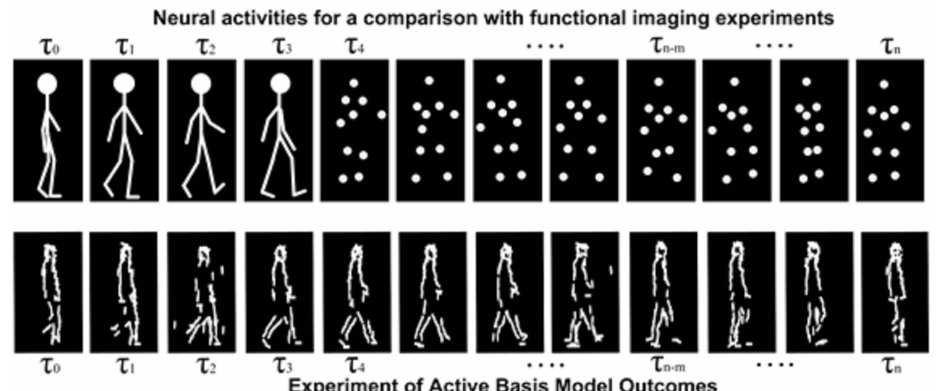
Figure 2. A illustrative similarity comparison of MLD and ABM [15] from the perception of biological movements. These basis have considerable consistency to the point light technique (MLD), which presents static pictures. ABM also has a good representation of biological movements in form pathway. Picture is adapted from